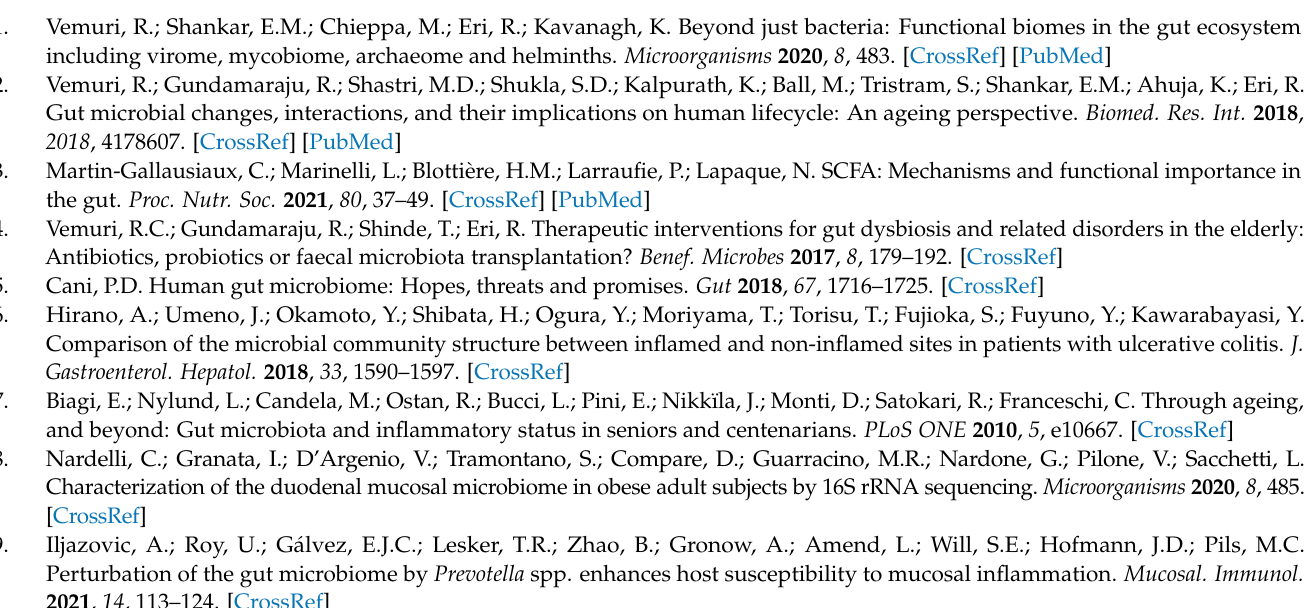
10.3390/nu14050977/s1, Figure S1: Bacterial taxa identified to be differentially abundant by linear discrimination analysis (LDA) effect size (LEfSe, log LDA > 2.0) analysis in all 4 samples at the phylum level (A) and genus level (B). The values are shown as the mean ± SEM. * Significant differences with p < 0.05. Figure S2: Summary of co-occurrence and co-exclusion analysis between young and aging mice at the phylum and genus levels in fecal (A,B), mucosal (C,D), and cecal (E,F) samples. (YC) Young control group, (YP) young probiotic group, (AC) aging control group, and (AP) aging probiotic group. Table S1: Nutritional composition details of Barastoc mice standard chow. Table S2: Summary of fecal microbiome co-occurrences between young and aging mice at phylum and genus levels based on Kendall’s Tau correlation analysis, after which FDR ( q < 0.05) correction was performed. Table S3: Summary of mucosal microbiome co-occurrences between young and aging mice at phylum and genus levels based on Kendall’s Tau correlation analysis, after which FDR ( q < 0.05) correction was performed. Table S4: Summary of cecal microbiome co-occurrences between young and aging mice at phylum and genus levels based on Kendall’s Tau correlation analysis, after which FDR ( q < 0.05) correction was